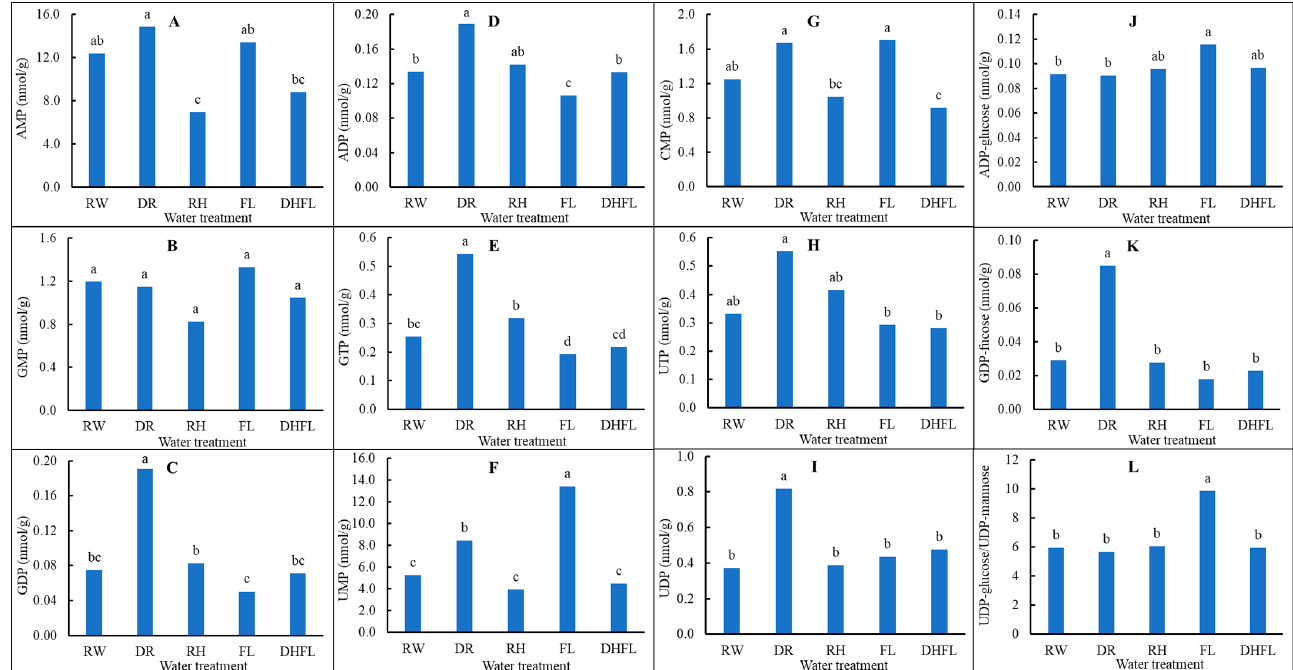
Figure 6. Changes in nucleotide biosynthetic pathway metabolites in Mexican mint ( Plectranthus amboinicus ) plants in response to varying watering regimes (n = 3). ( A ) Adenosine monophosphate (AMP), ( B ) guanine monophosphate (GMP), ( C ) guanine diphosphate (GDP), ( D ) adenosine diphos- phate (ADP), ( E ) guanine triphosphate (GTP), ( F ) uridine monophosphate (UMP), ( G ) cytosine monophosphate (CMP), ( H ) uridine triphosphate (UTP), ( I ) uridine diphosphate (UDP), ( J ) ADP- glucose, ( K ) GDP-fucose, and ( L ) UDP-glucose/UDP-mannose. Di ff erent alphabetical le tt ers on the bars denote signi fi cant di ff erences according to Tukey’s honestly signi fi cant di ff erence post-test analyses at a signi fi cant level of p < 0.05.